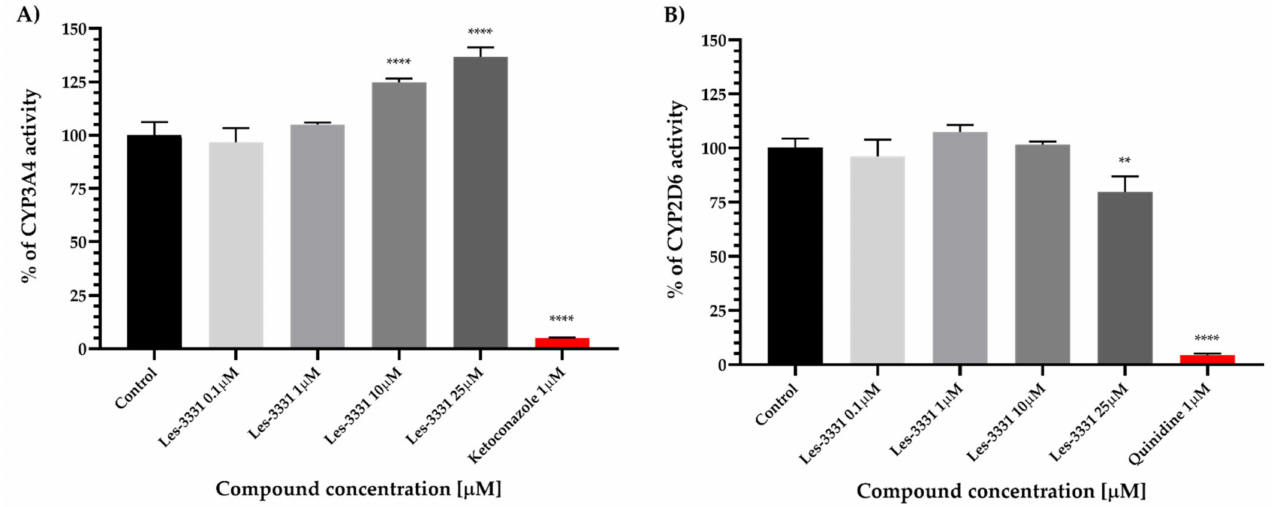
Figure 15. The effect of ketoconazole and Les-3331 on CYP3A4 activity ( A ). The effect of quinidine and Les-3331 on CYP2D6 activity ( B ). Statistical significance was calculated using one-way ANOVA with Bonferroni multiple comparison test. Differences were considered statistically significant at ** ( p < 0.01), **** ( p ≤